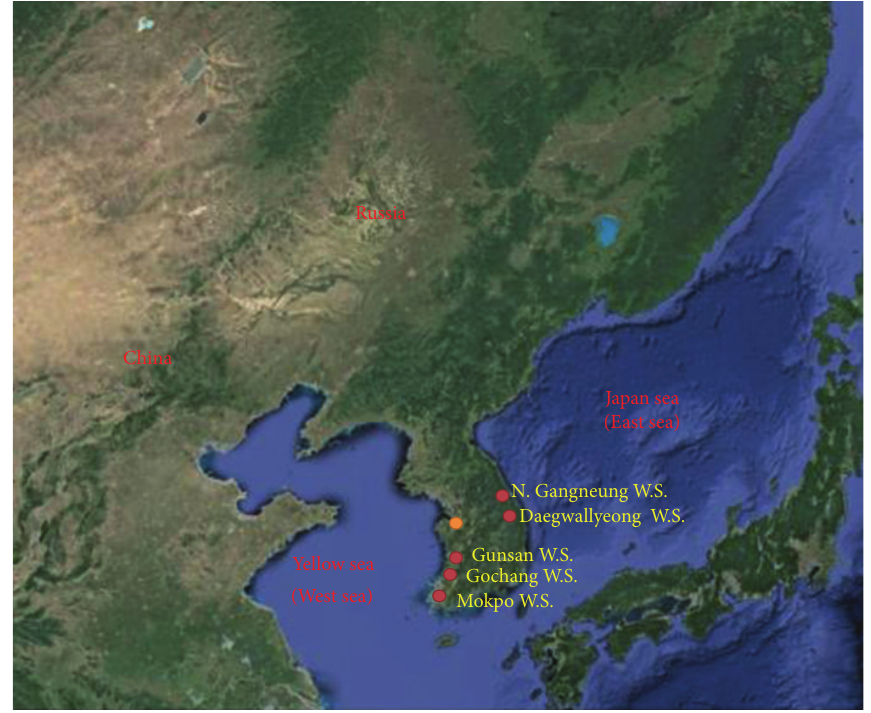
Figure 1: Location of weather